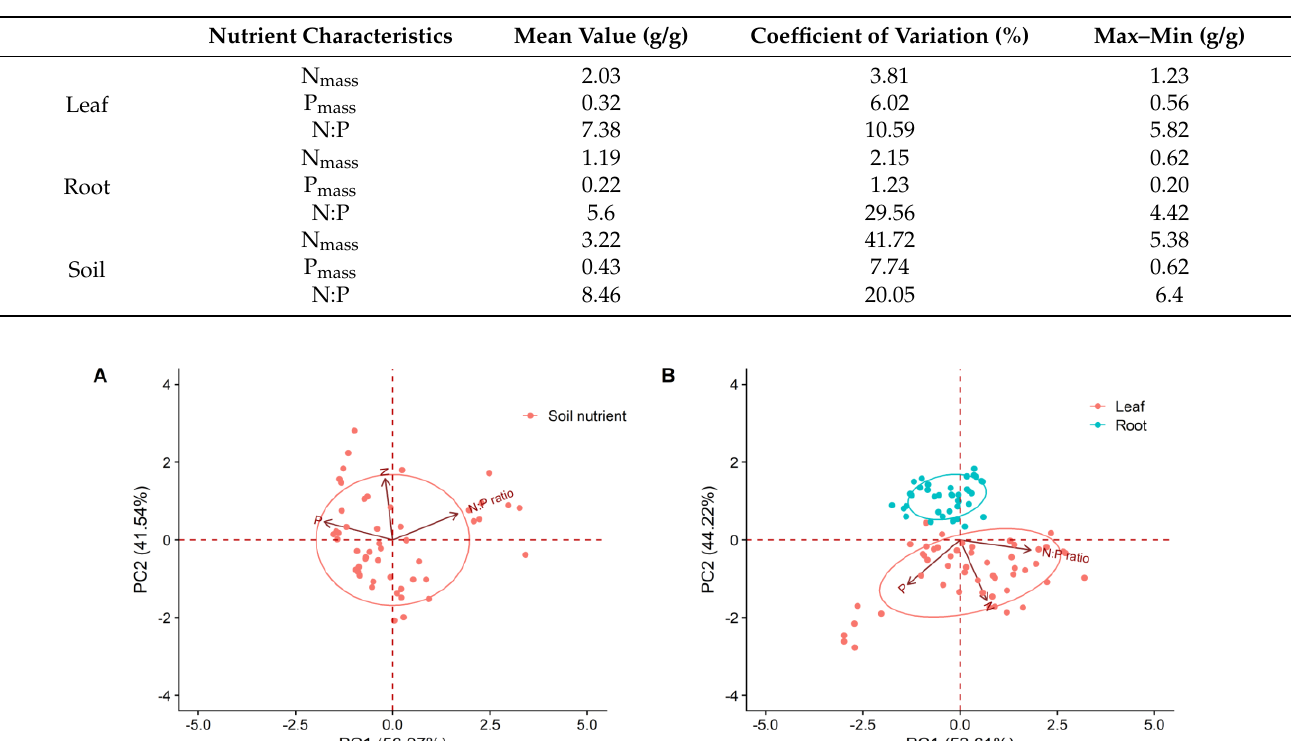
Figure 2. Principal component analysis (PCA) of nutrient characteristics of ( A ) soil and ( B ) leaves and roots. Nutrient characteristics included the N mass , P mass and N/P ratio.